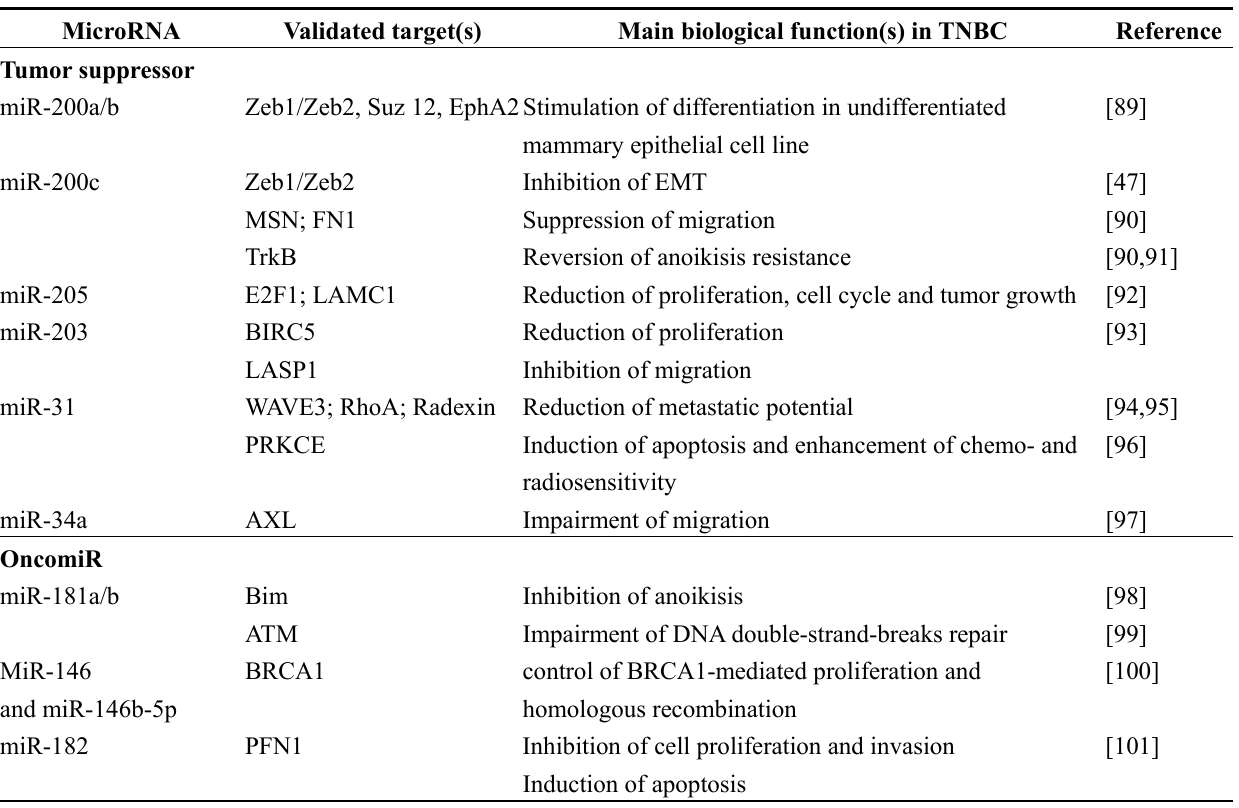
Table 1. Summary of microRNAs involved in Triple Negative Breast Cancer (TNBC), with relative validated targets and biological